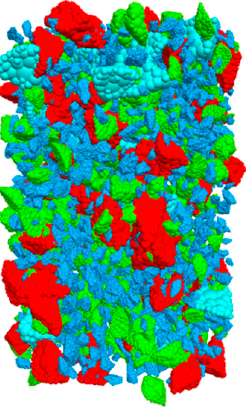
Figure 9. Aggregate distribution of asphalt mixture in DEM